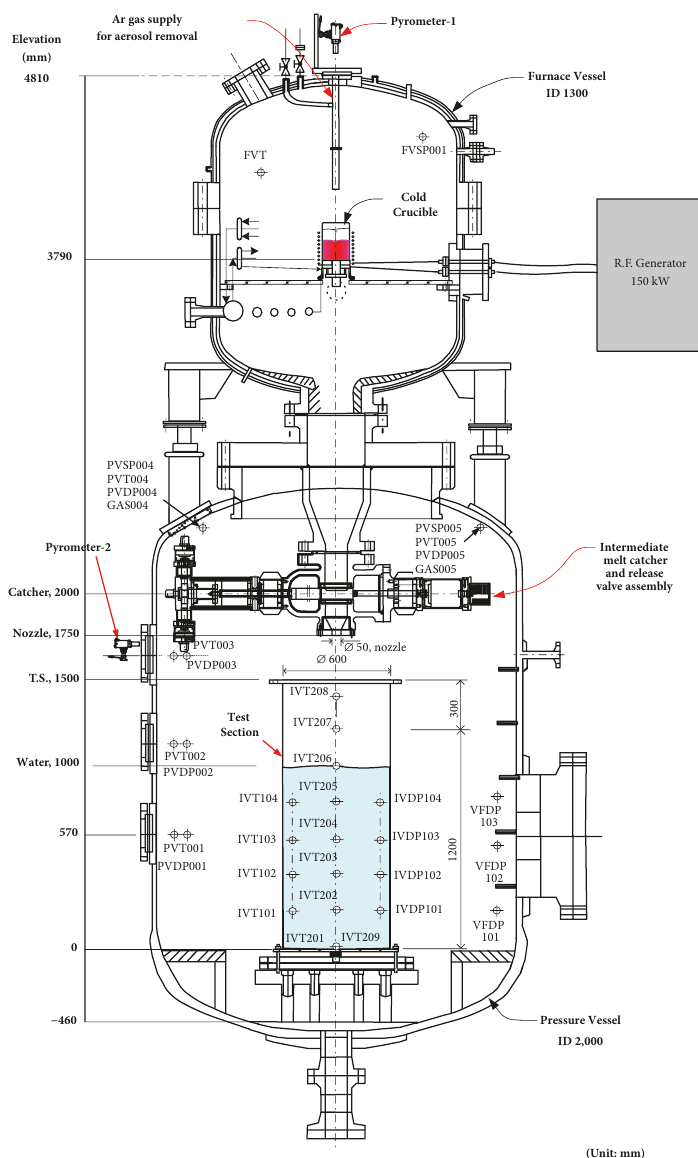
Figure 2: Schematics of TROI-68 experimental facility for partially flooded